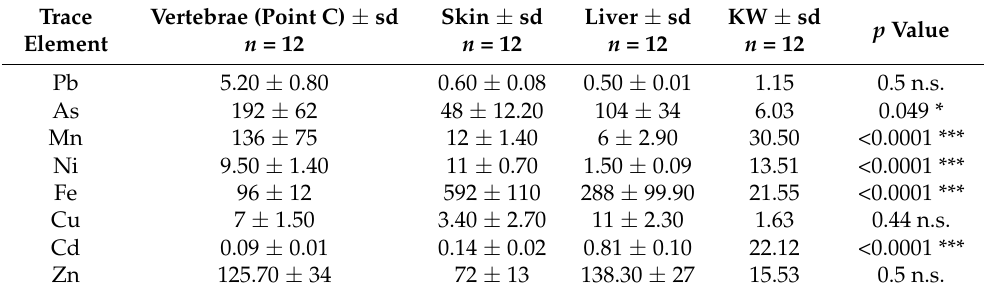
Table 5. Trace element concentrations (ppm) in target tissues expressed as mean ± sd; KW: Kruskal– Wallis value; n.s.: not significant; * significant (significance at 10%), *** extremely significant (signifi- cance at